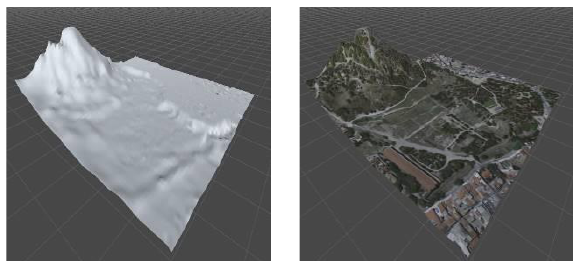
Figure 11: Untextured terrain (left) and textured terrain